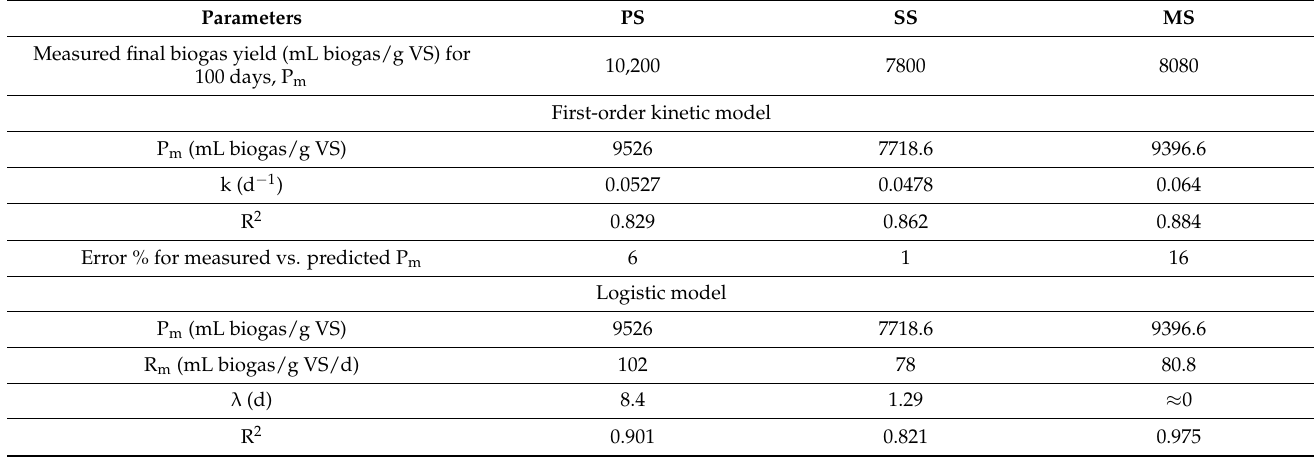
Figure 6. Predicting the design parameters from well-known First-order kinetic and Logistic models for three sewage sludge as substrates (PS, SS and MS) using the TAD reactor. Table 3. Predicted design parameters from first-order kinetic and logistic